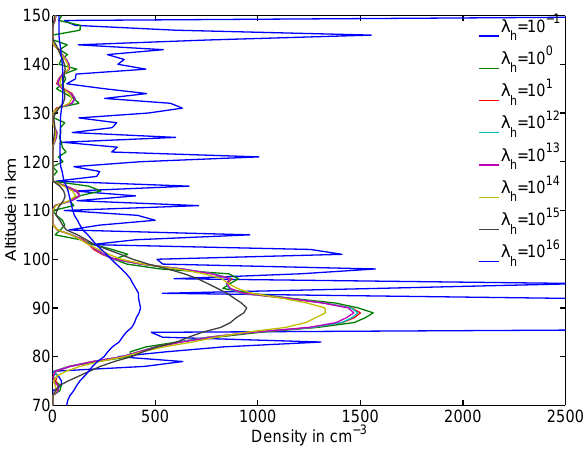
Fig. 29. Retrieval results with a 1-D model when an error is applied for Mg with the same method as for the blue line in Fig. 21. The con- straint strength is varied. Oscillating results start at a much higher constraint strength than for the error-free case shown in Fig. 28. Furthermore, the result varies much stronger with changing con- straint strength, so that it is once again difficult to find the con- straint strength for the optimal solution. For the case of very strong smoothing, the same profiles as in the error-free case are retrieved for the same constraint